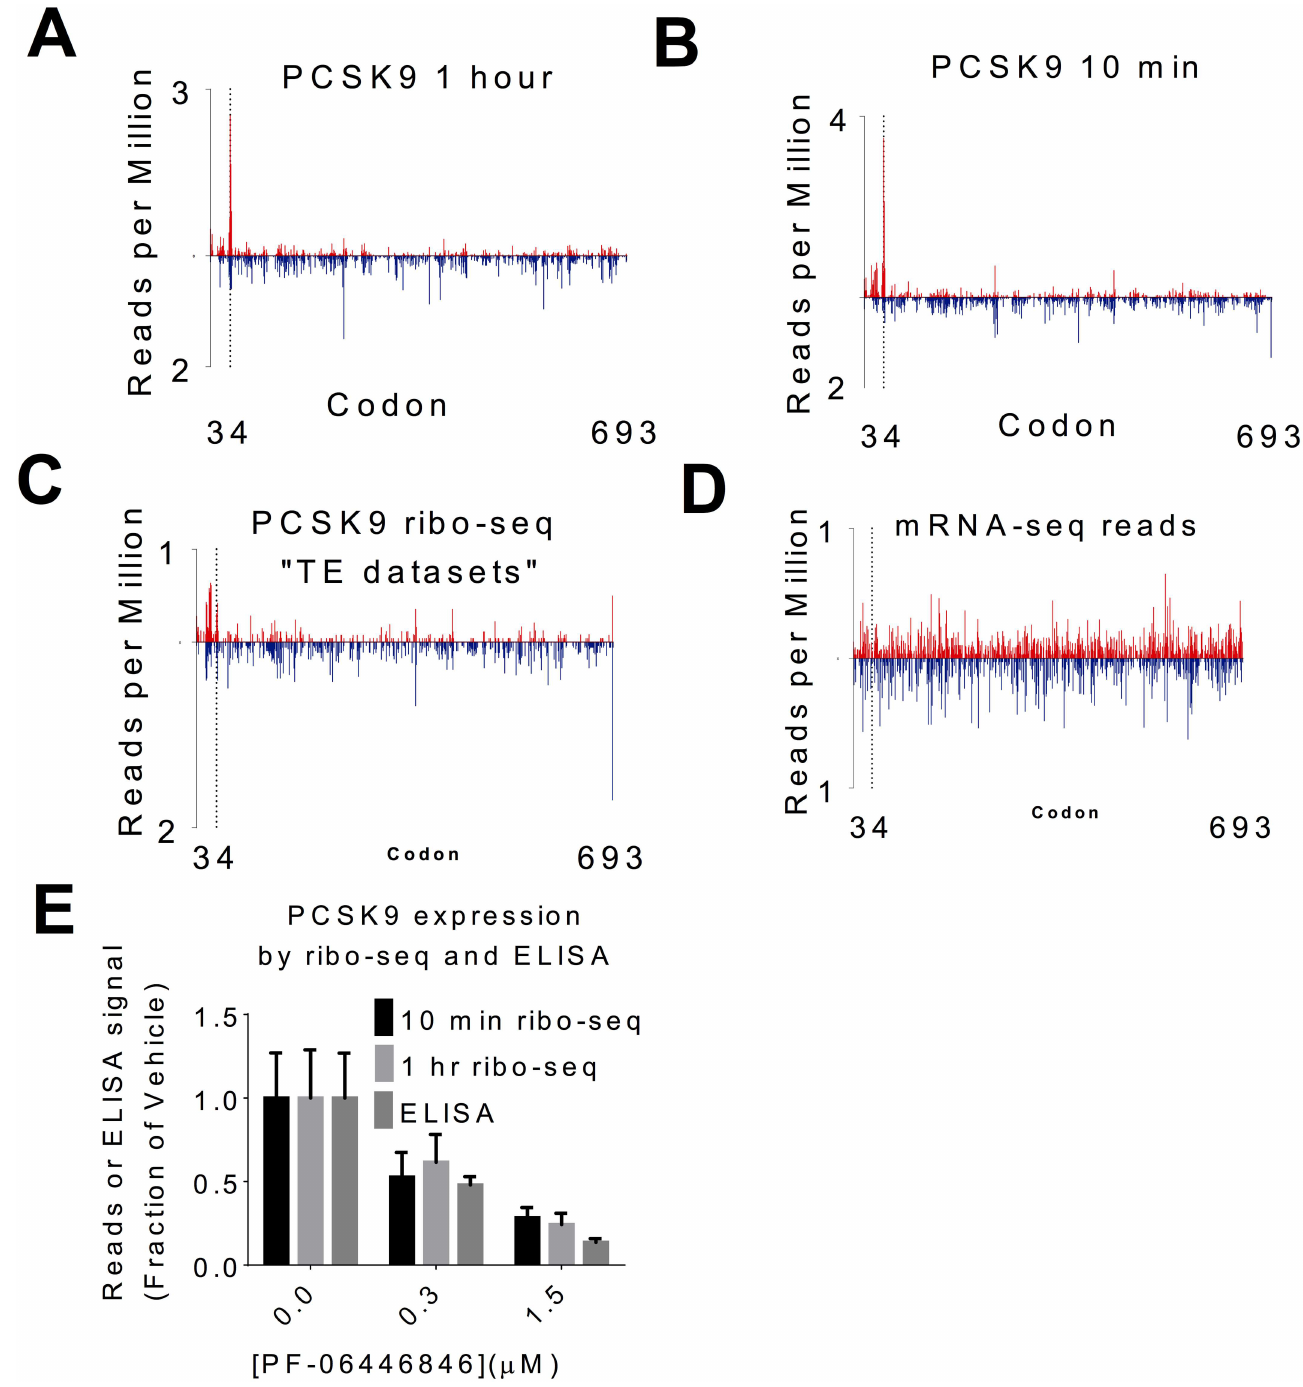
Fig 4. The PF-06446846–induced stall site is revealedby ribosome profiling. (A–D) Ribosomefootprint density plots displayingthe numberof reads aligningto a given codonper million total reads for the proproteinconvertasesubtilisin/kexin type 9 (PCSK9) codingregionfrom Huh7 cells treated for (A) 1 h and (B) 10 min. (C) Ribo-seqdatasets from the second study and (D) mRNA-seq datasets from the second study. The upwardred bars indicate readmaps from cells treated with 1.5 μ M PF-06446846 and the blue downwardbars represent vehicle. In panelsA–D, read positionsare mapped accordingto inferred location of the ribosomeP-site [19]. (E) The footprint density downstream from the stall in the 10-min treatment (black) and 1-h treatment (light grey) comparedwith PCSK9 expressionas measuredby ELISA (middle grey). Error bars represent one standarddeviationof three replicates.The individualquantitative observations that underlieFig 4E are in S14 Table.